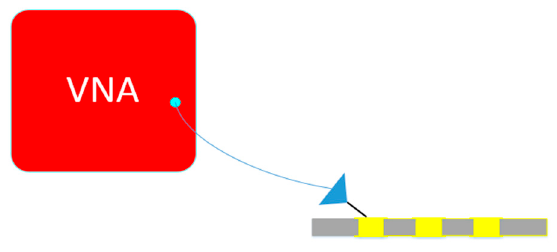
Figure 6. The de-embedding methodology and broadband microprobe.